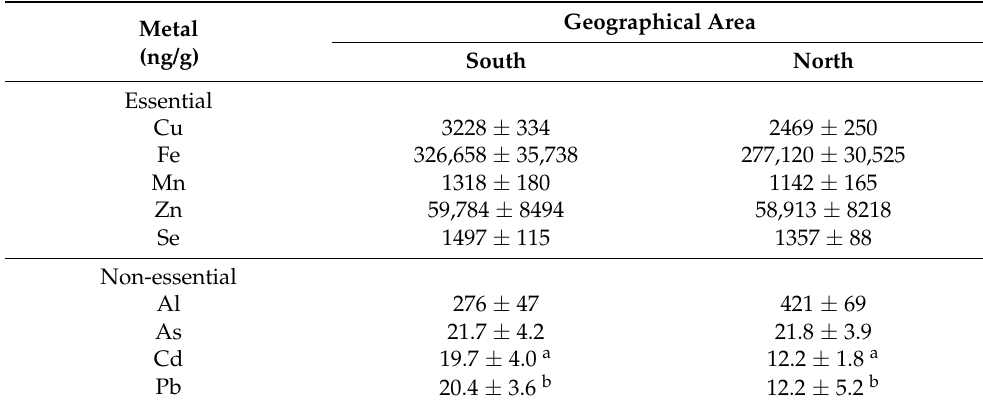
Table 3. The levels of essential and non-essential metals (mean ± SEM) in ovarian tissues of free- ranging bitches inhabiting two different areas of Sardinia.